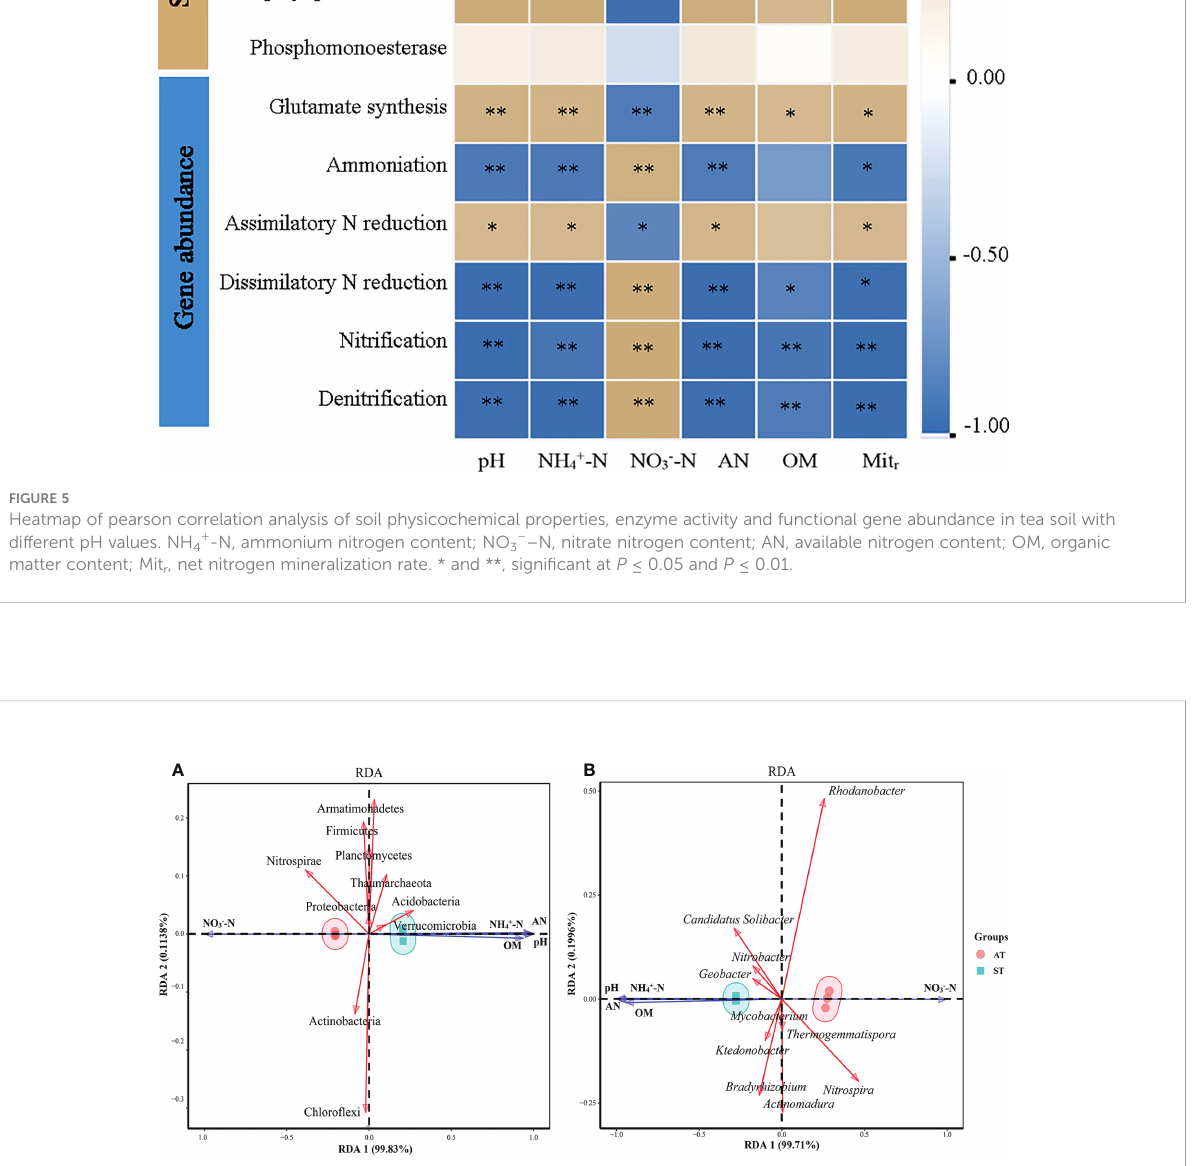
FIGURE 6 Canonical redundancy analysis (RDA) of soil physicochemical factor and dominant phyla (A) and genera (B) microorganism in three soil sample. AT, tea soil with a pH of 3.75; ST, tea soil with a pH of